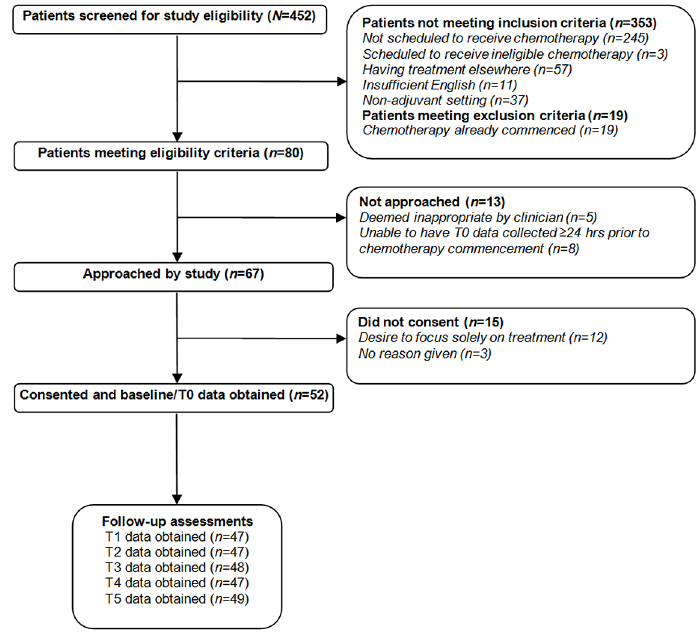
Figure 2. CONSORT diagram reporting numbers of individuals at each stage of the study.